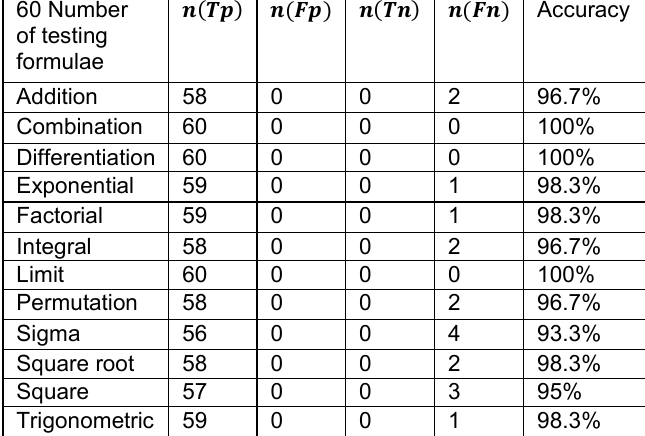
Table 21. The above tabulated value represents overall Accuracy Measure with Tensorflow from a document of 60 samples.